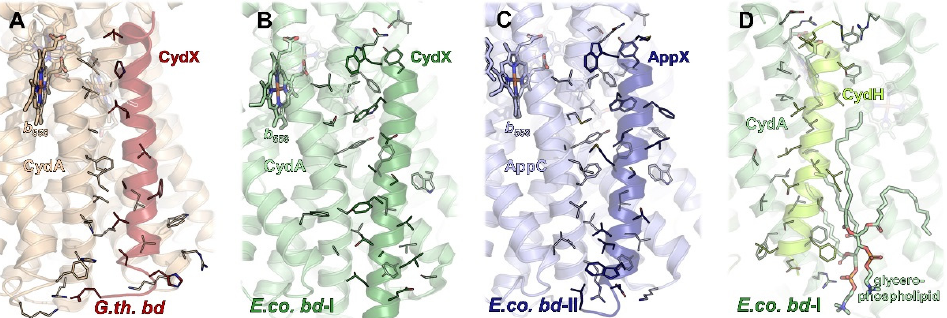
Figure 4. Interaction interfaces of additional subunits with the bd core subunit CydA/AppC . ( A – C ) Subunit CydX/AppX (bold colours) binds to subunit CydA/AppC (light colours) in a largely conserved position close to heme b 558 , lateral to the Q binding site (not shown). Interactions are mainly driven by hydrophobic contacts. ( A ) Interaction patterns between CydX and CydA in G. thermodenitrificans bd . ( B , C ) CydX/AppX of E. coli bd ‐ I and bd ‐ II bind in a nearly identical manner to CydA/AppC, underlining the close homology of both bd oxidases. As compared to G. thermodenitrificans bd , the N ‐ terminus (top) of CydX/AppX is tilted further away from heme b 558 . ( D ) Subunit CydH (limon), exclusive to E. coli bd ‐ I, is found at the opposite side of CydA (light green) and appears to be further stabilised by a glycerophospholipid (shown as sticks). Again, mainly hydrophobic interactions contribute to binding.